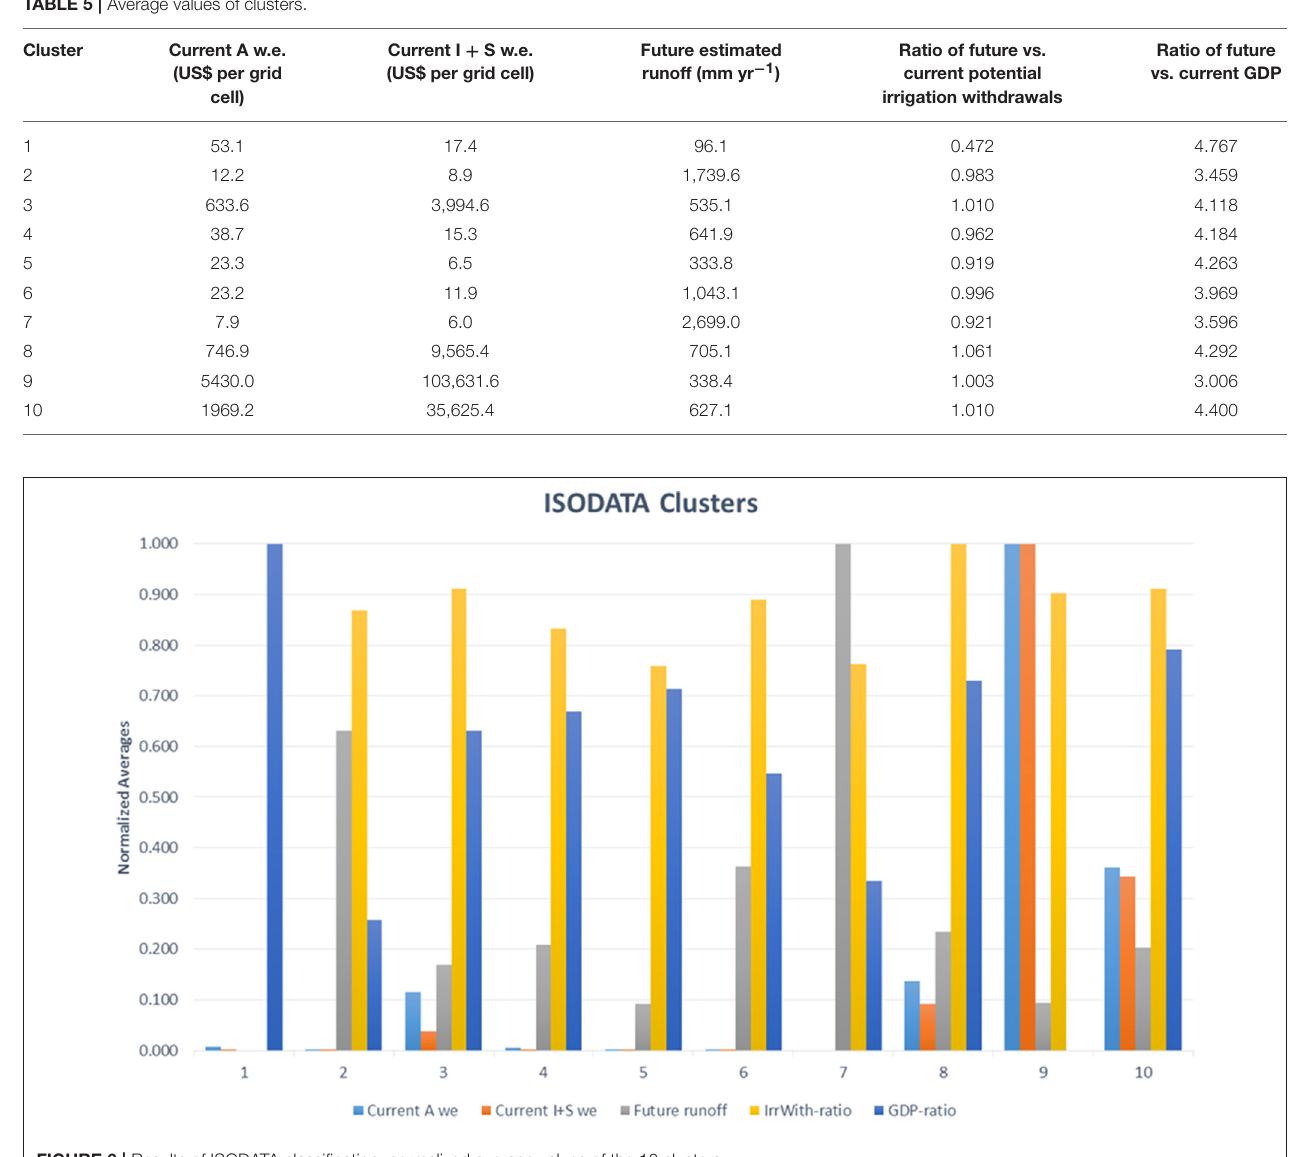
FIGURE 6 | Results of ISODATA classification: normalized average values of the 10